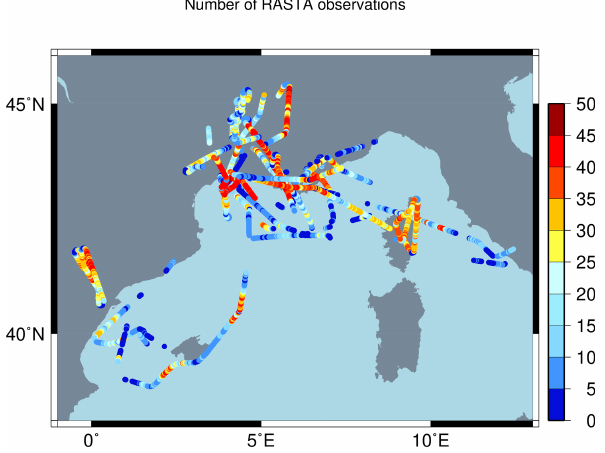
Figure 5. Location of RASTA observations during the first HyMeX special observation period. Coloured dots represent the number of wind data available per profile.